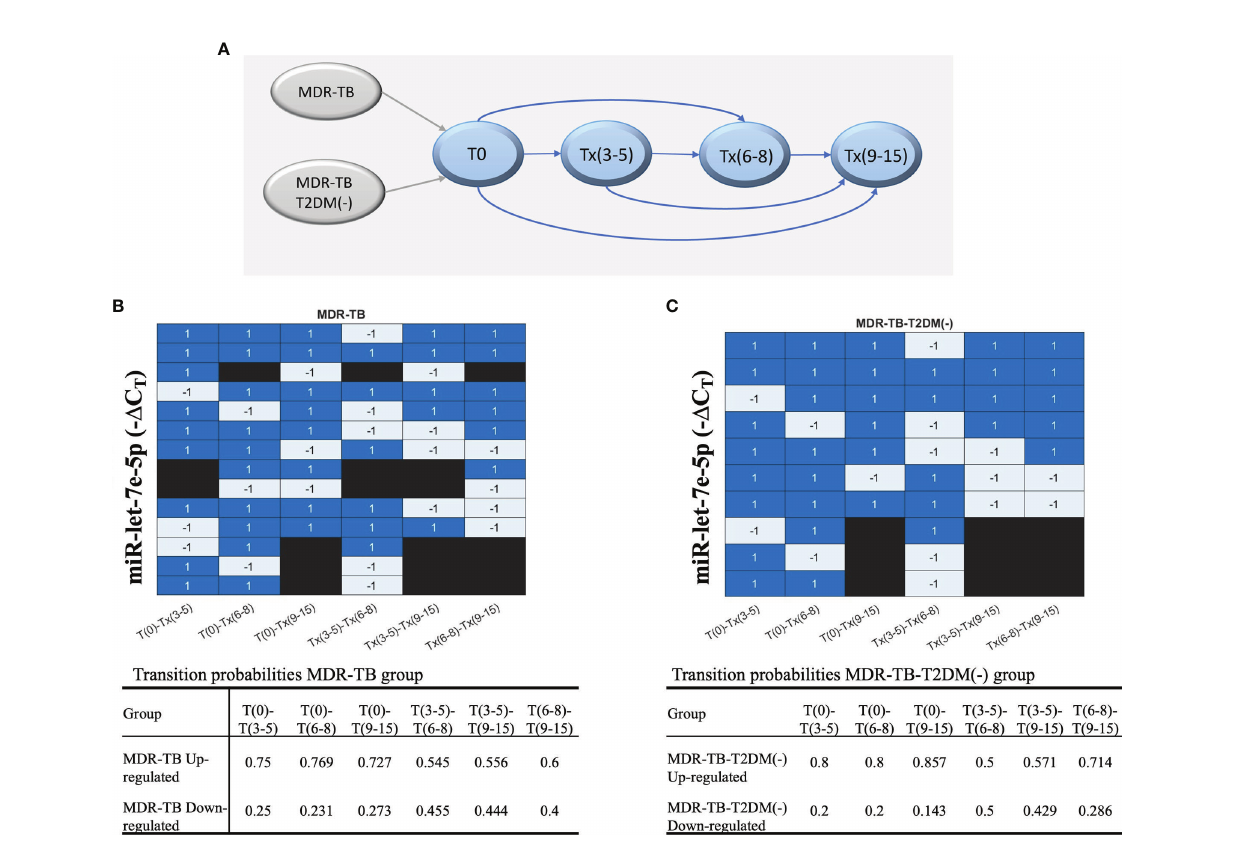
FIGURE 5 | The behavior of each group of patients, showing the evolution of each patient according to the D C T values during the periods of time. (A) The transitions model comparing six times. Upregulation or downregulation in the D C T value between time points is illustrated in a heatmap. Blue: upregulation in the D C T value in the next time point or the target time point; gray: downregulation in the D C T Cs value, and black: no transition between time points. (B) MDR-TB group and (C) MDR-TB-T2DM (-) group. The table includes results of the transition probabilities of the two groups: MDR-TB, MDR-TB-T2DM(-). Each group is divided at the same time point into 2 subgroups according to the D C T values of transition: upregulated or